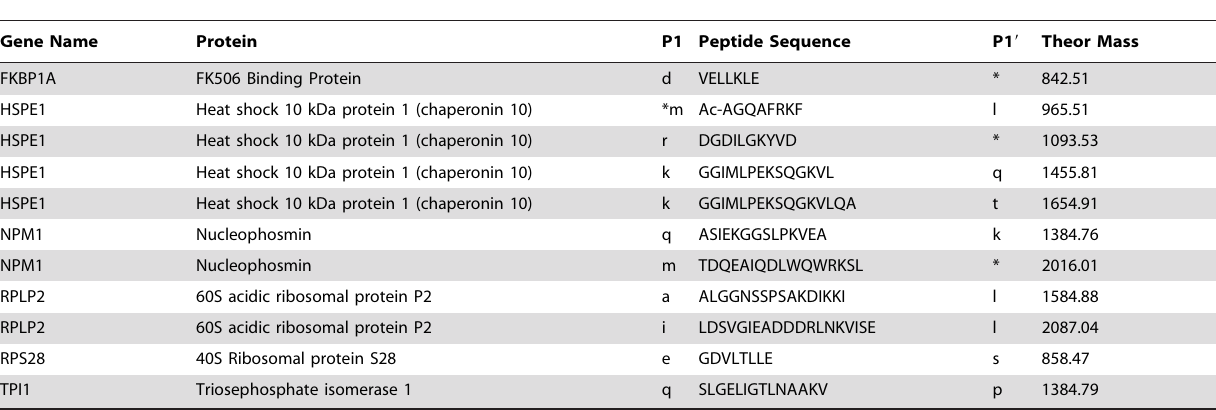
Table 3. Peptides elevated by treatment of cells with proteasome inhibitors.